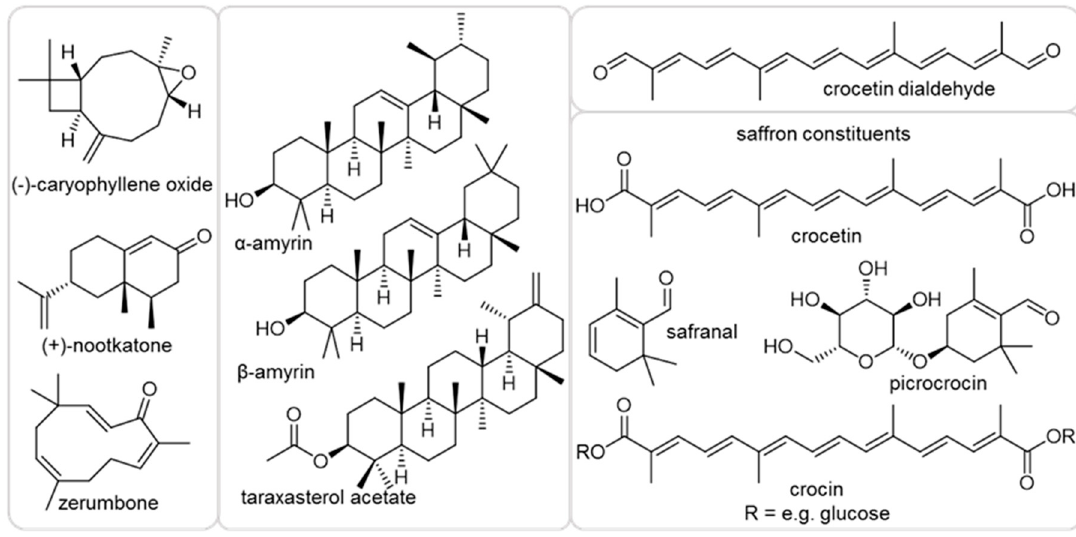
Figure 1. Chemical structures of the compounds used in this work.